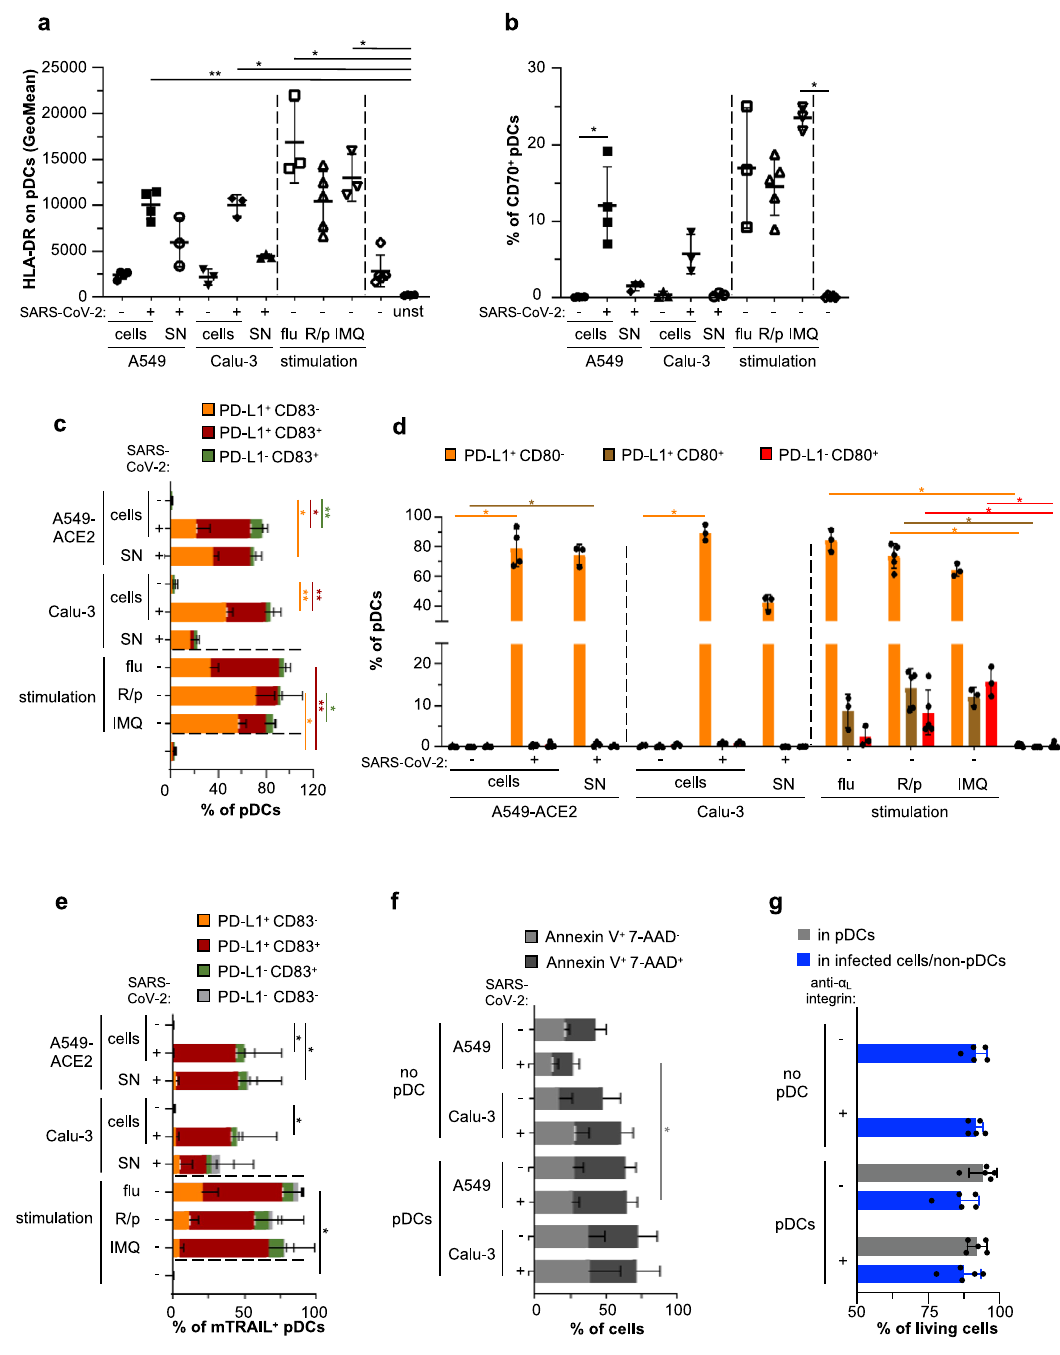
Fig. 3 | SARS-CoV-2-infected cells induce pDC maturation and phenotypic diversi fi cation. Human pDCs isolated from healthy donors were cocultured with SARS-CoV-2-infected [+] or uninfected [ − ] A549-ACE2 or Calu-3 cells (indicated as [cells]), or were stimulated with 100 µ l of cell-free supernatants [SN] collected immediately prior coculture from the corresponding SARS-CoV-2-infected cells (viraltiters ≈ 2.5×10 5 ffu/ml-MOI ≈ 1/pDCs),orwerestimulatedwithin fl uenzavirus [ fl u] (viral titers ≈ 10 7 pfu/ml - MOI ≈ 0.5/pDCs), R848/polyI:C [R/p] or imiquimod [IMQ] for 14 – 16h, [unst]; unstained. a – e , Quanti fi cation by fl owcytometryofHLA- DRGeomean( a )orthefrequencyofpDCspositiveforCD70( b ),PD-L1and/orCD83 ( c ), PD-L1 and/or CD80 ( d ), PD-L1 and/or CD83 among mTRAIL + pDCs ( e ) deter- mined in gated pDCs (live cells + singulets + CD123 + BDCA-2 + , see the gating strategy inSupplementaryFig.3a). f SARS-CoV-2-infected[+]oruninfected[-]A549-ACE2or Calu-3 cells were cultured alone [no pDC] or cocultured with pDCs for 14 – 16h.